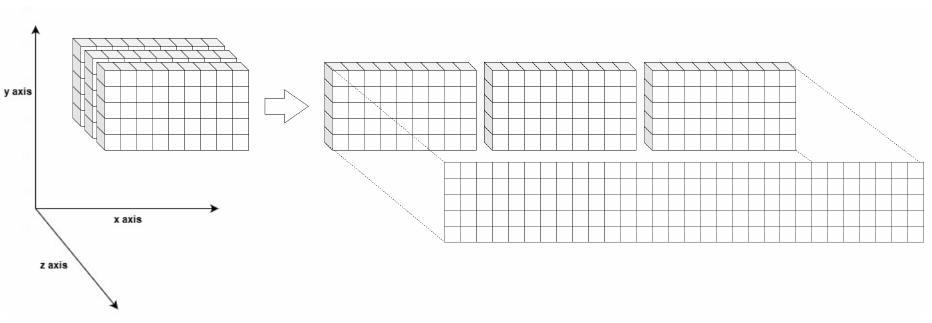
Figure 6. Multi-flow as a two-dimensional space. The x axis stands for the number of features, y represents the number of samples and z describes the number of time